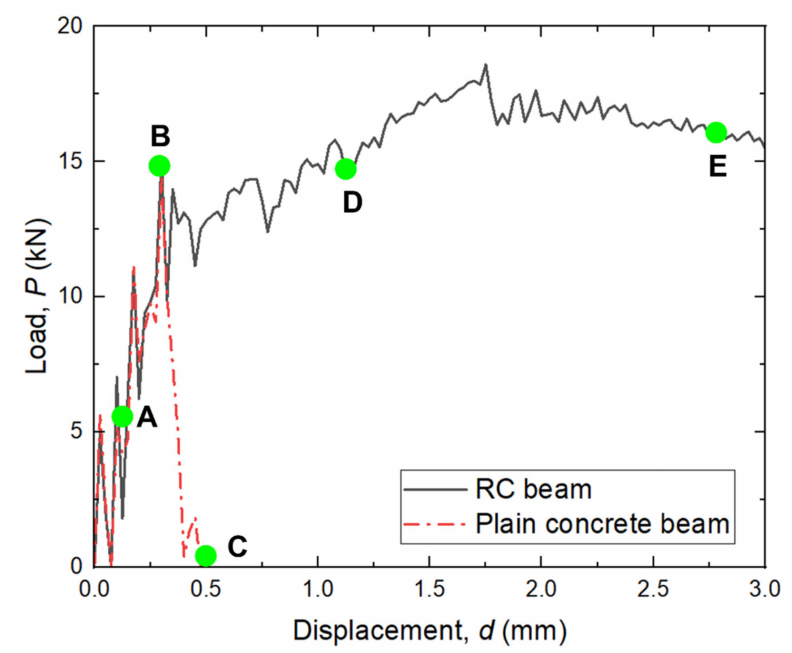
Figure 11. Loading–displacement curves of the simulation in three-point bending testing for the RC and plain concrete beam.